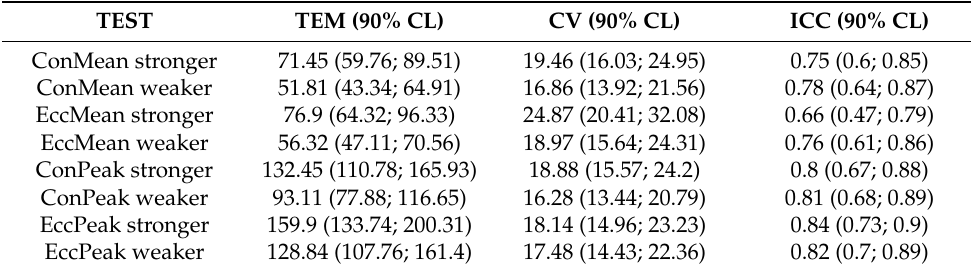
Table 2. Measures of reliability in strength performance test ( n = 45).